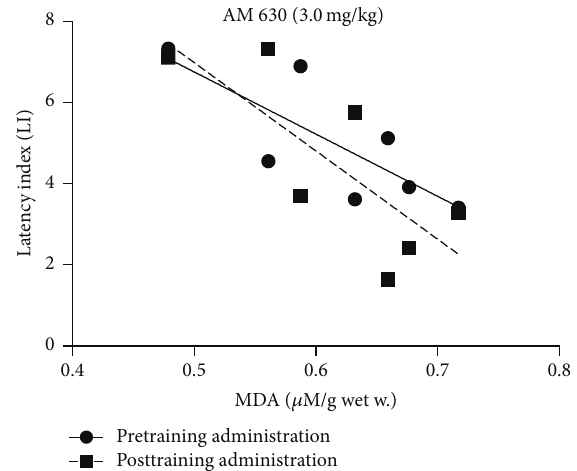
Figure 7: Correlations between the change in LI values in the PA test for the acquisition or consolidation of long-term memory and the concentration of MDA in the mice brain induced by the acute pretraining or posttraining injection of CB2 receptor antagonist AM 630 at the dose of 3.0 mg/kg.